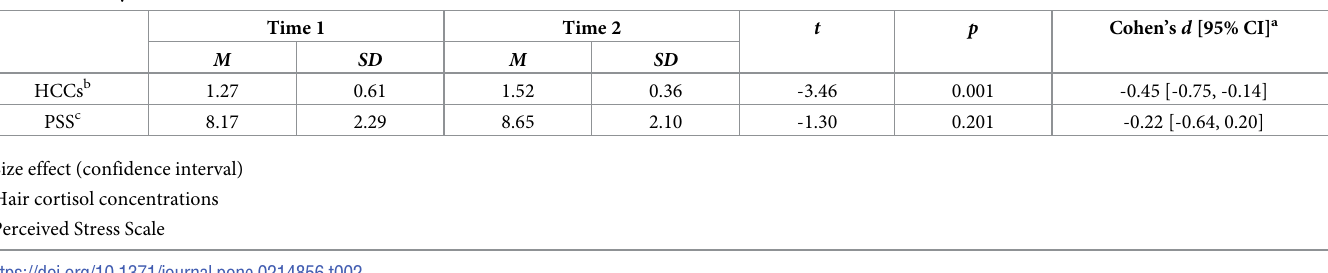
Table 2. Stability of HCCs at 6